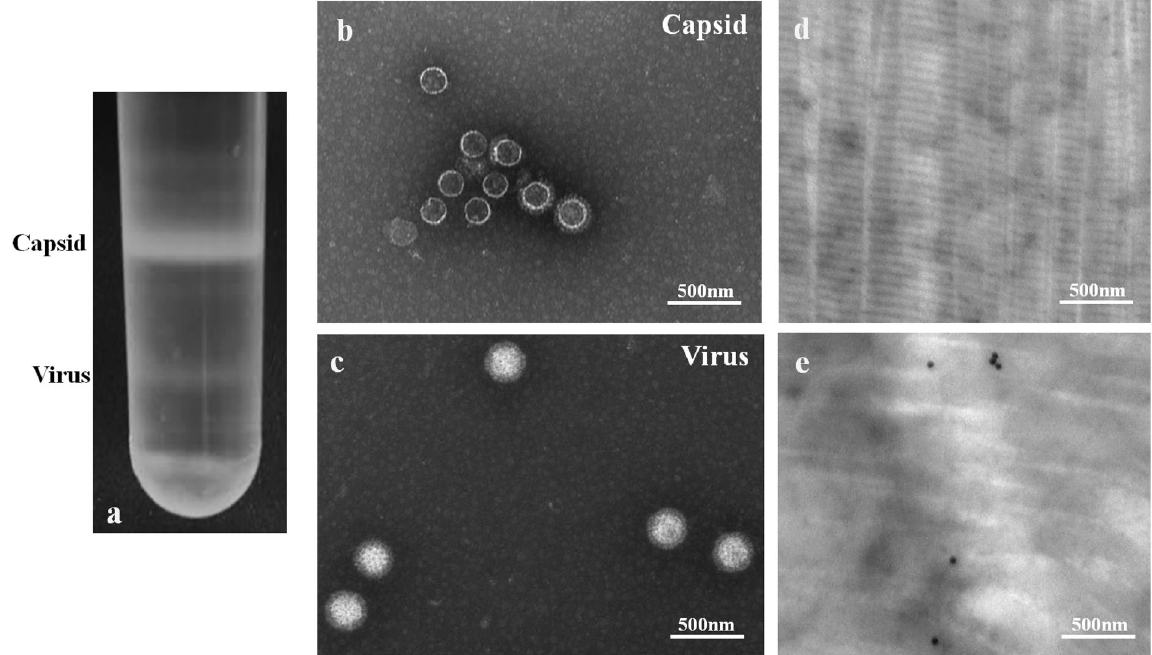
Figure 2. Virus purification and TEM, as well as ultrathin sectioning of tendon tissues and immunogold labelling TEM. ( a ) CsCl density gradient purification of ARV virus isolate showing bands of mature virions and empty capsids. ( b ) Negative staining TEM of purified empty capsids. ( c ) Negative staining TEM of mature ARV particles. ( d ) and ( e ) Ultrathin sectioning and immunoglod labeling using anti-ARV antibody of non-infected (d) and ARV infected ( e ) tendon tissues after negative staining